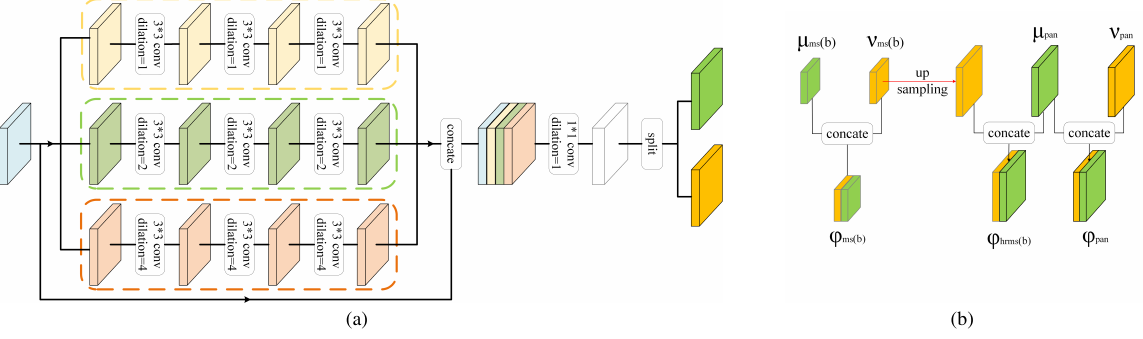
Figure 3. Detail structure of the encoder and the FEM. (a) is the encoder. (b) is the